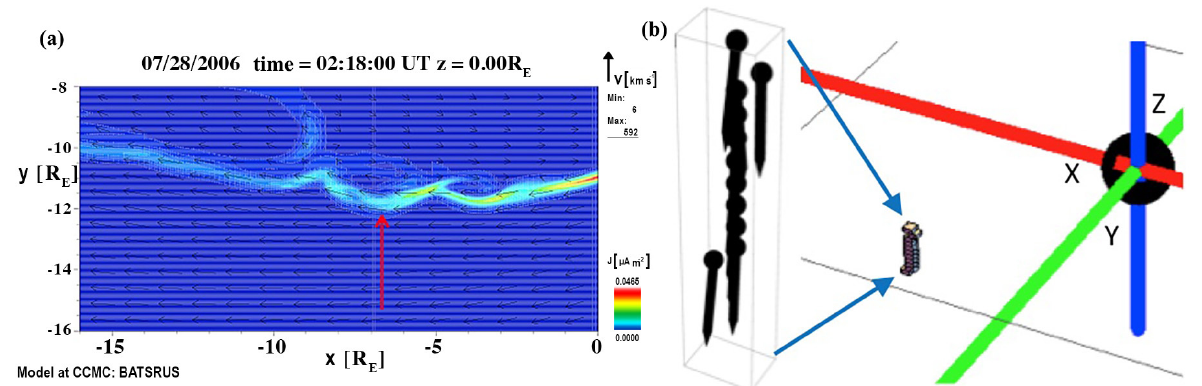
Figure 5. 3-D representation of the vorticity vectors from the structure found on the Z = 0 cut plane around X = − 6 . 75 R E and Y = − 10 . 75 R E (shown at the left). The tool can give more information on the extent of the vorticity vectors (shown in black screwlike sym- bols – center) and where they are located in the magnetosphere domain, with the x , y and z axes represented in red, green and blue colors, respectively (shown at the